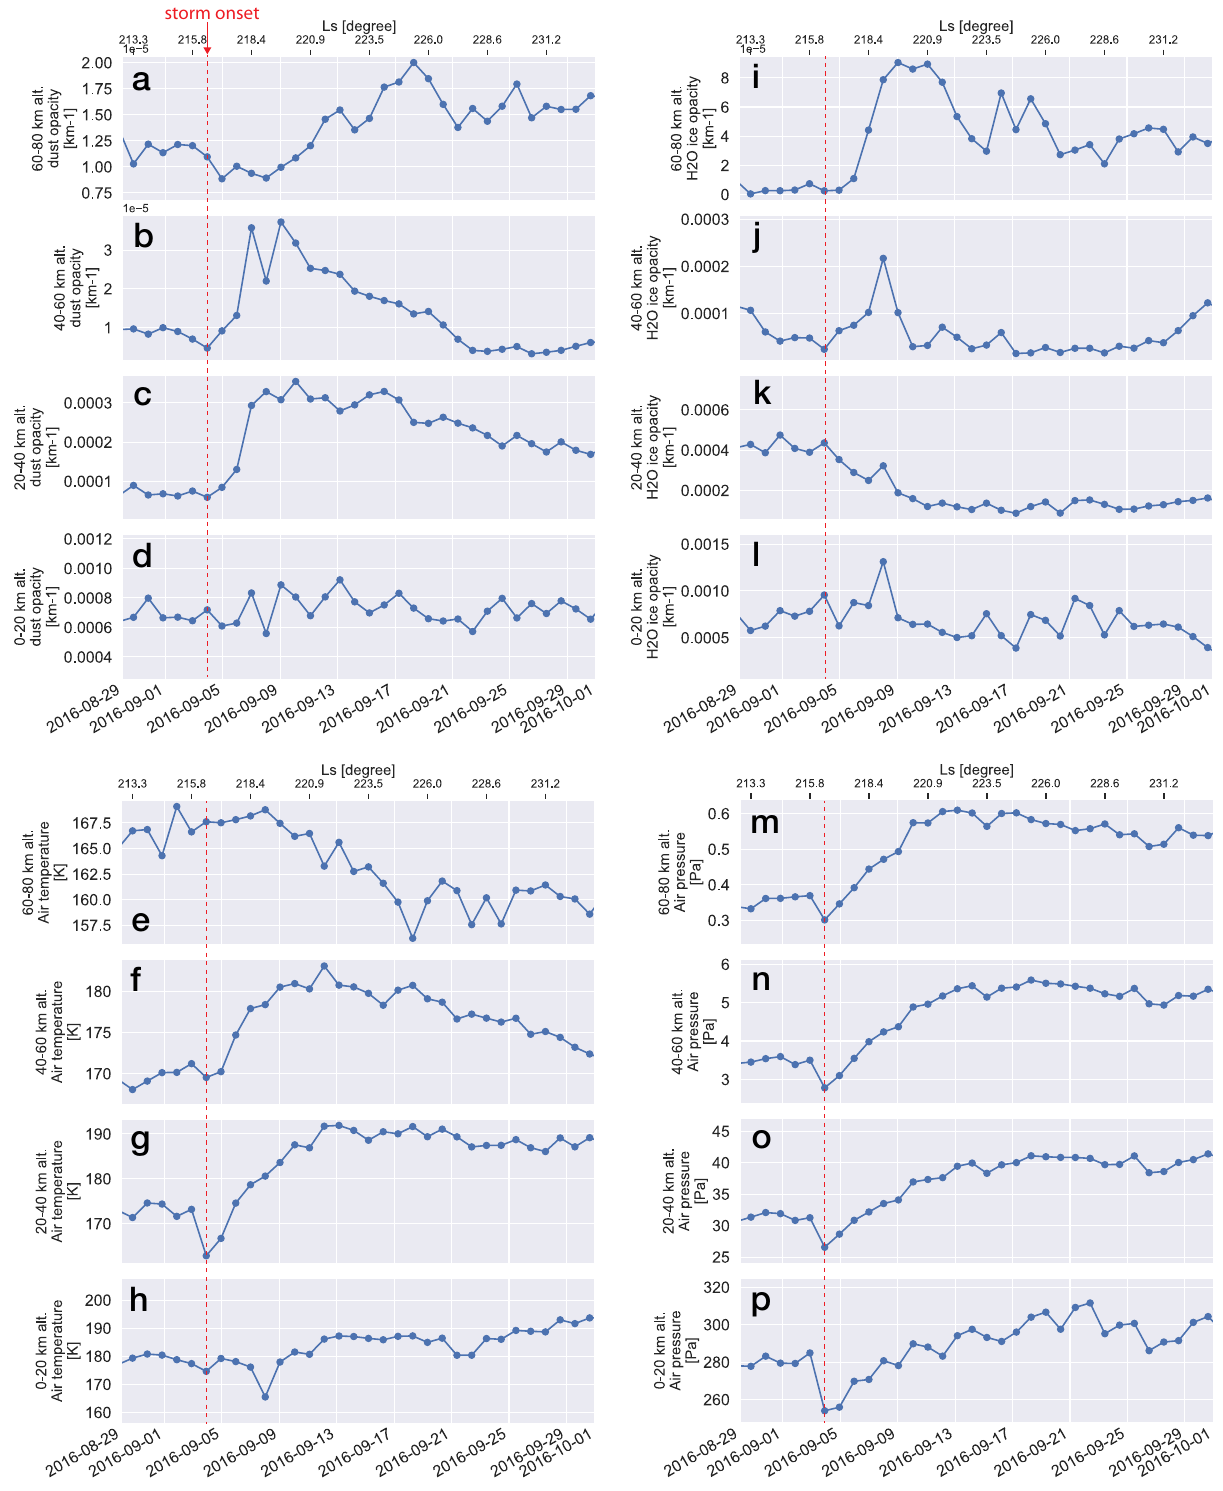
Fig.1|EvolutionoftheregionalduststorminMarsYear33. Timeseriesof( a – d ) dustopacity,( e – h )airtemperature,( i – l )H 2 Oiceopacity,and( m – p )airpressure,as observed by the Mars Climate Sounder (MCS) limb observations at altitudes of